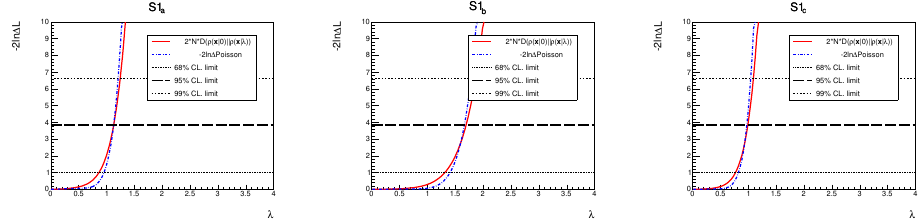
Figure 15 . Upper limits on the coupling strength parameters of the S1 benchmark scenarios. KL-divergence term 2 N D ( (cid:26) ( x 0) (cid:26) ( x (cid:21) )) in (cid:12)gure 14 for the S0 benchmark scenarios and (cid:1) j jj j in (cid:12)gure 15 for the S1 benchmark scenarios. The shapes provide signi(cid:12)cant improvements in all cases. The KL-divergence terms drive the (cid:12)nal limits for the S0 benchmark scenarios and are close to the normalization terms in the S1 benchmark